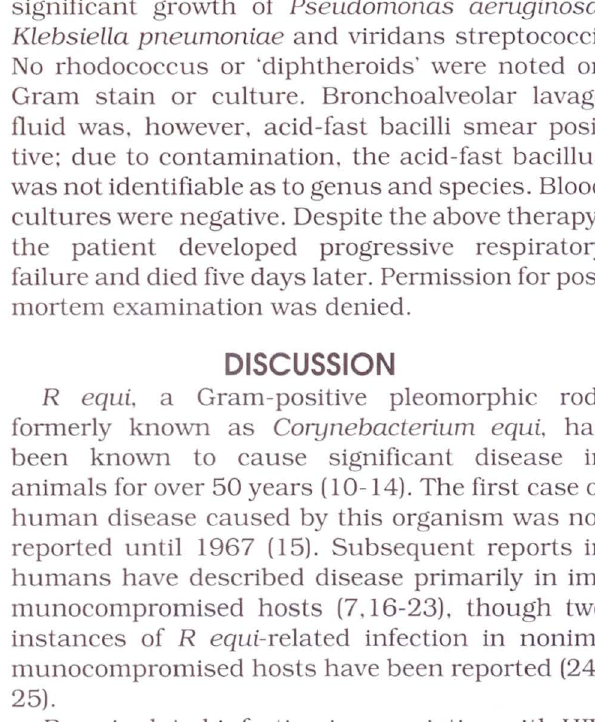
Figure 3) Posteroanterior roentgenogram revealing wor sening of right lower lobe process and new left upper lobe infiltrate I